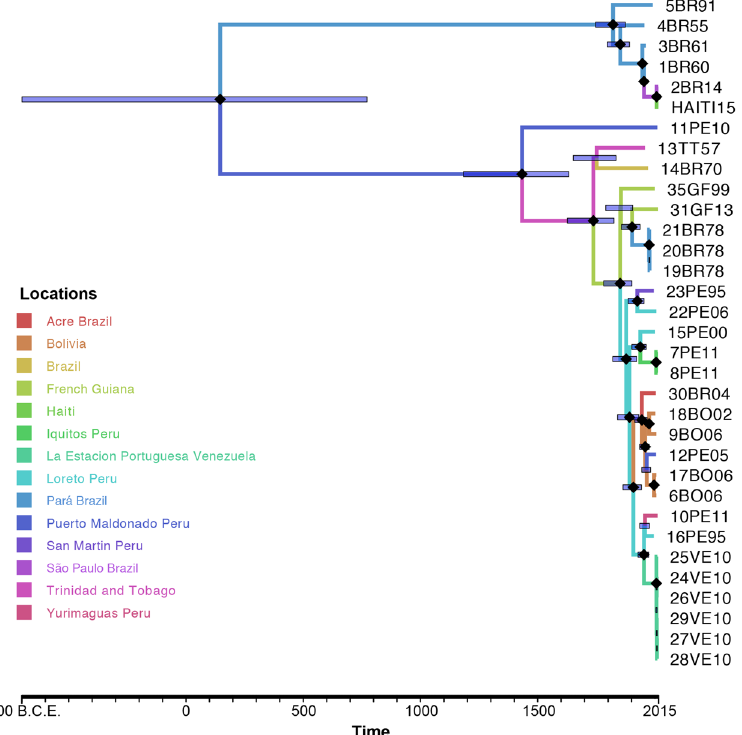
Figure 5. Bayesian phylogeographic analysis of MAYV non-recombinant fragment sequences. Time-scaled phylogenetic maximum clade credibility tree inferred using the Bayesian Skygrid demographic, strict molecular clock, and asymmetric phylogeographic diffusion models, implemented in BEAST v1.8.3. Branches are colored according to geographical location, and black diamonds represent branches supported by posterior probability >